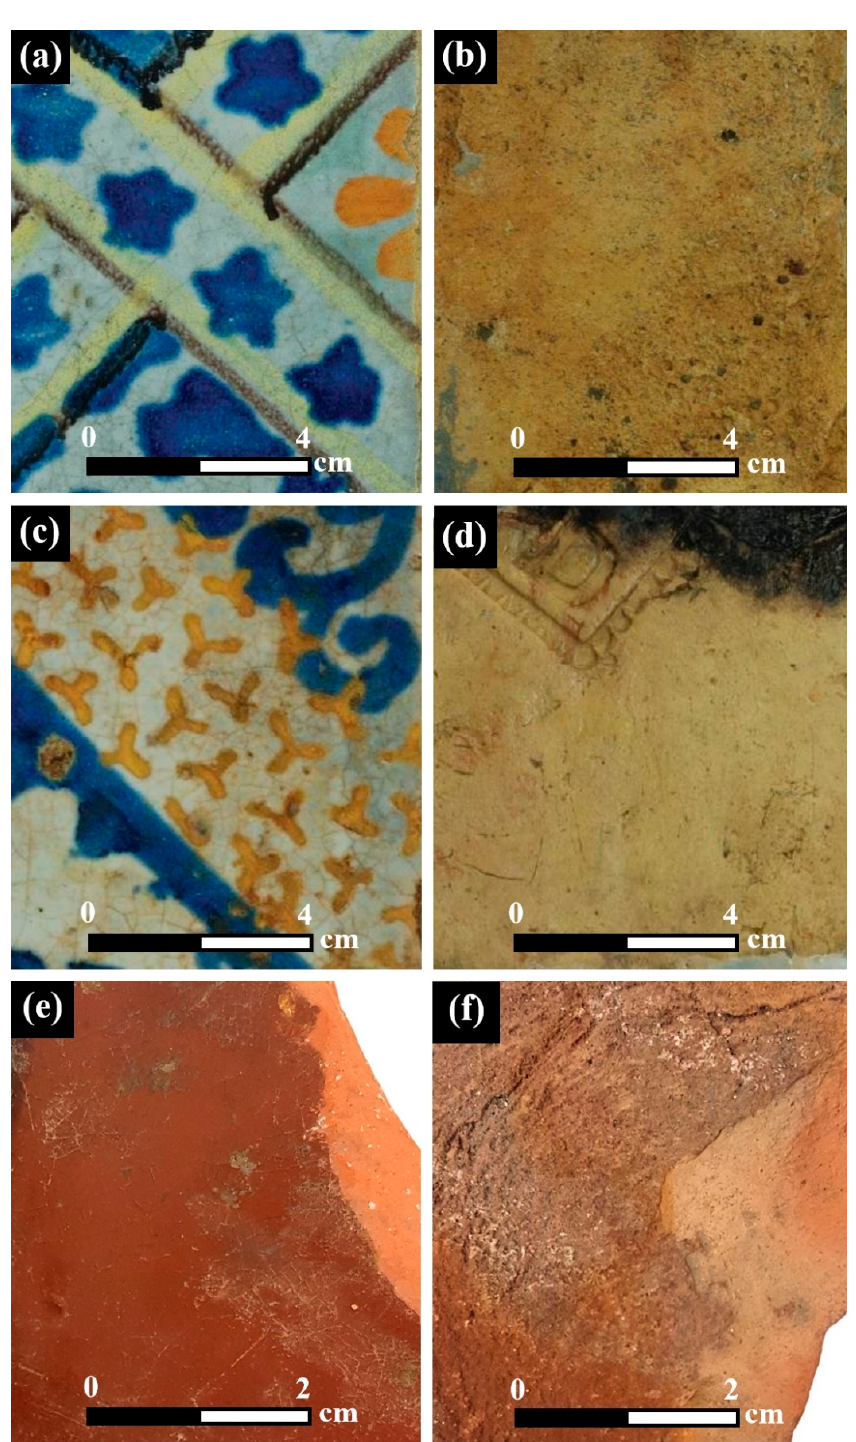
Figure 1. Decorated floor tiles: ( a ) front of tile no. 337 (Type A); ( b ) back of tile no. 337; ( c ) front of tile no. 323 (Type A); ( d ) back of tile no. 323; ( e ) front of tile no. 328 (Type B); and ( f ) back of tile no. 328 (photos: J. J. Gottlieb and D. Ashkenazi).